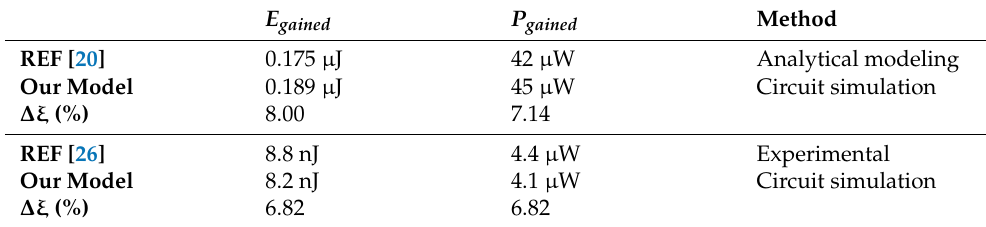
Table 3. Comparison between output parameters of different studies and our model calculations showing the relative absolute percentage errors of results with respect to